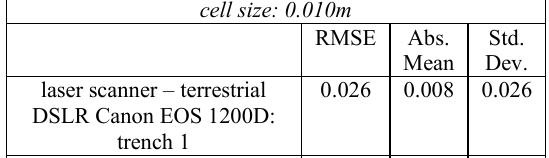
Scanner vs Aerial Sequoia MS.